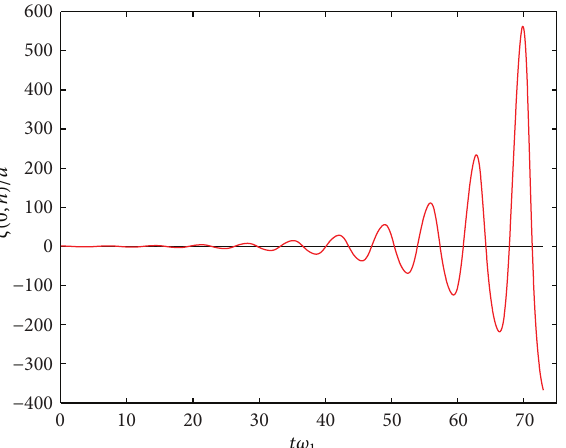
Figure 11: Free-surface elevation on the left wall in unstable region (test case 6) for Ω 1 = 0.55 , 𝑘 V = 0.5 , and 𝜀 = 0.0014 .